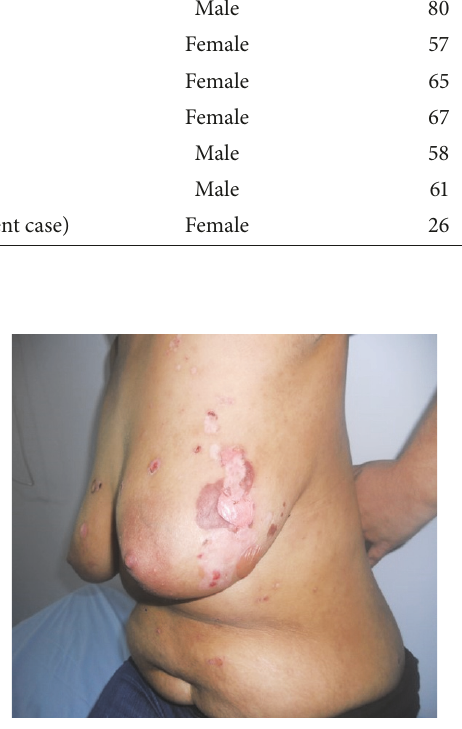
Figure 1: Clinical presentation of the patient; blisters, erosions, and remnants of blisters on her breasts and